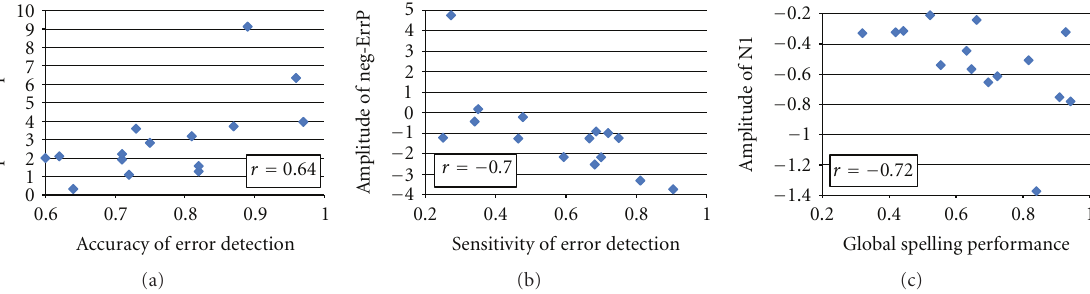
Figure 8: (a) Amplitude of pos-ErrP as a function of the accuracy of error detection (microvolts). (b) Amplitude of neg-ErrP as a function of the sensitivity of error detection (microvolts). (c) Amplitude of N1 as a function of the global spelling accuracy (microvolts). Each diamond represents a participant, and R values represent correlation coe ffi